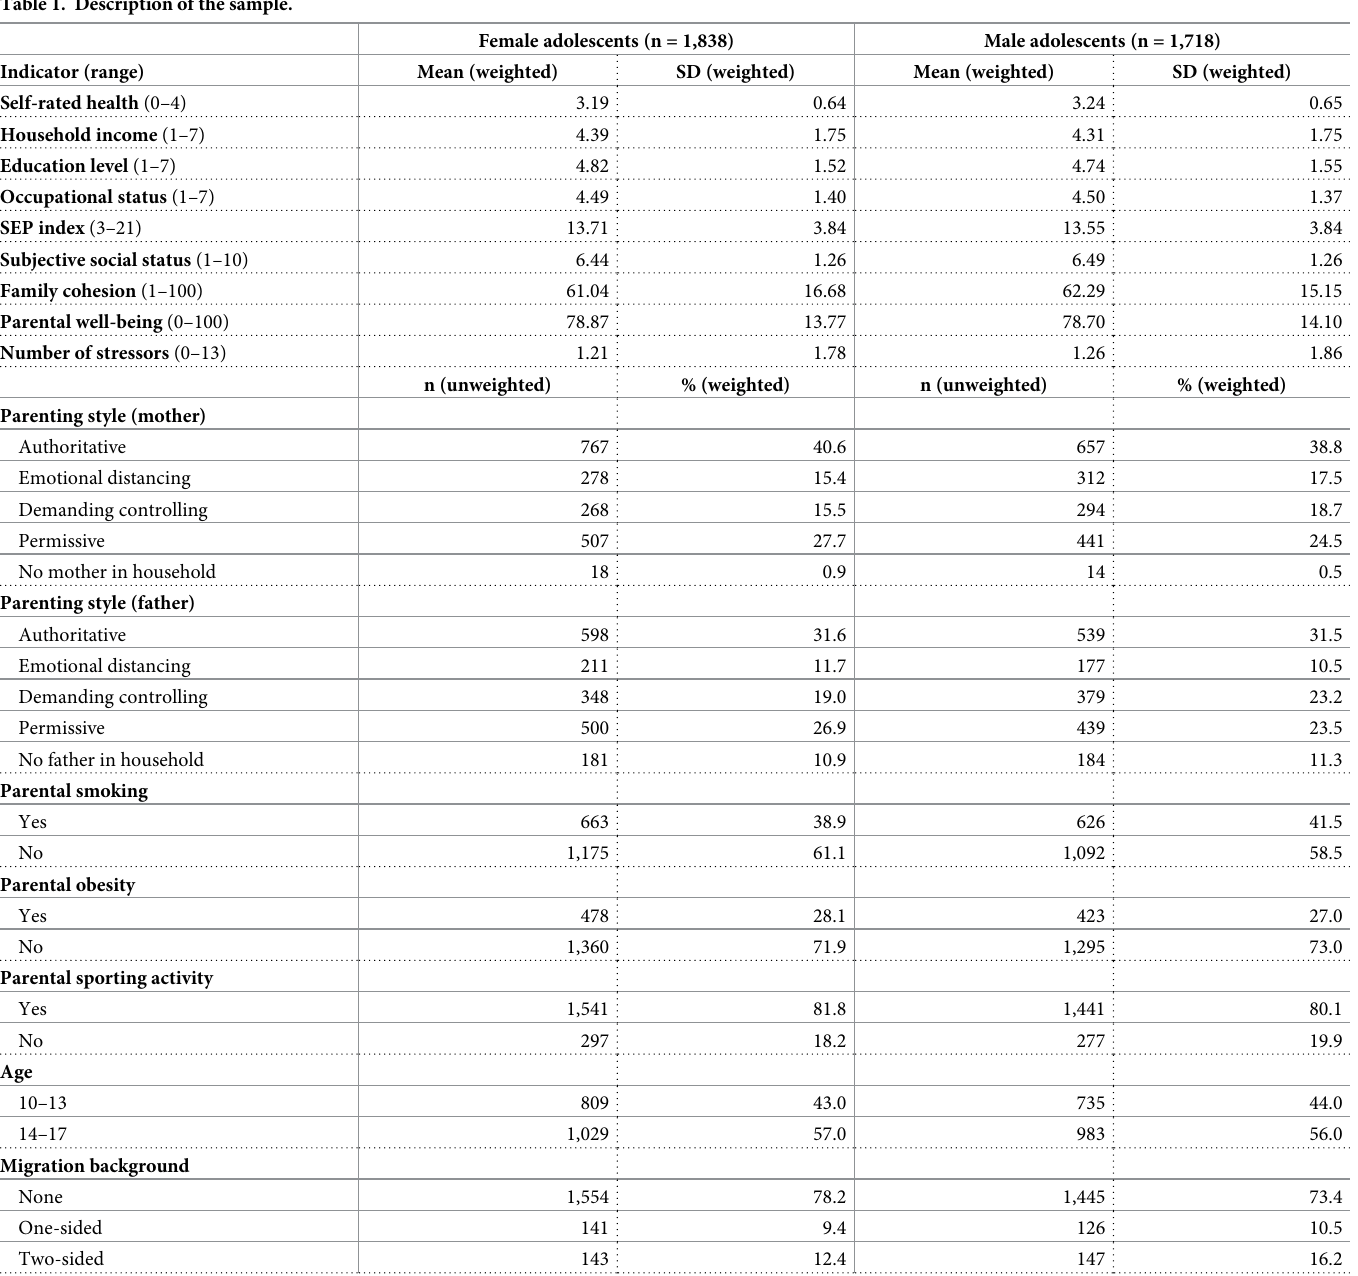
Table 1. Description of the